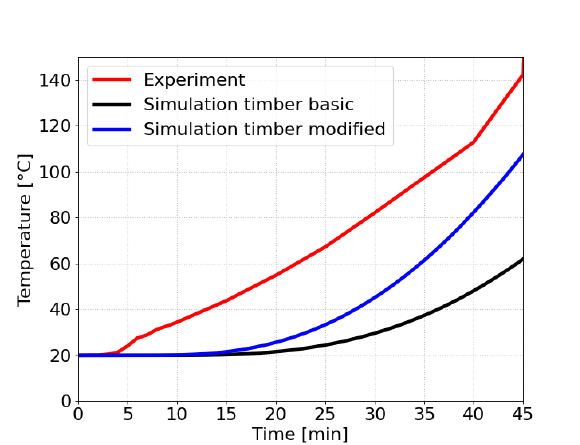
Figure 12. Comparison of experimental and simu- lated temperatures for the unprotected beam.